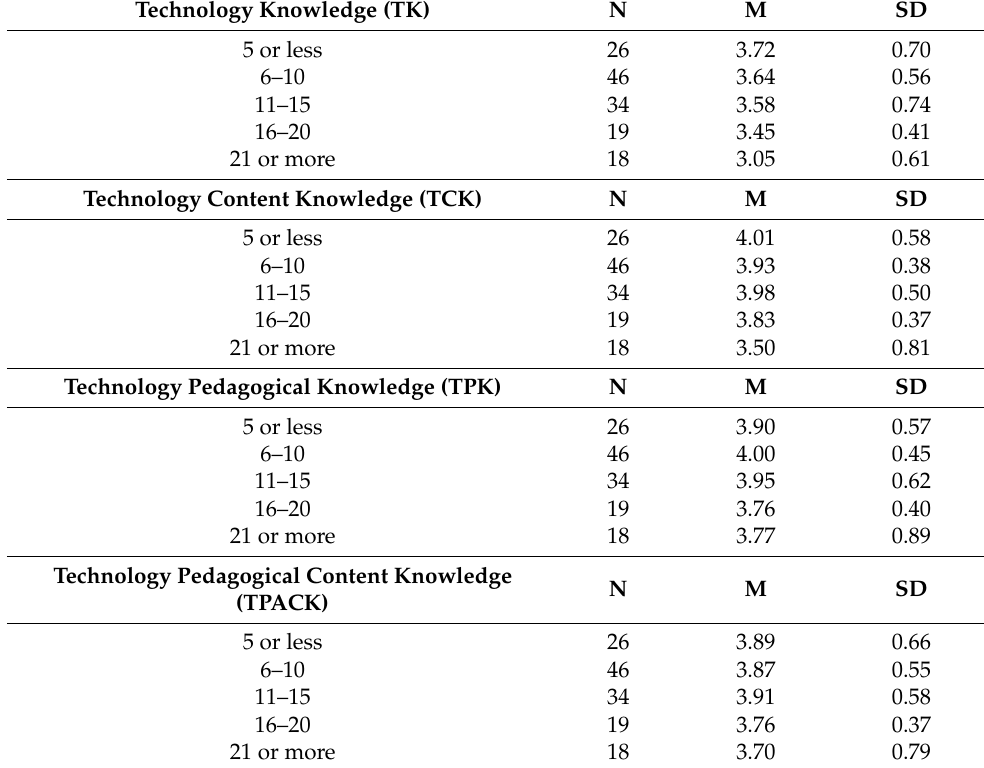
Table 6. t -test Analysis by Teaching Experience on TK, TCK, TPK, TPACK) constructs (n = 143).